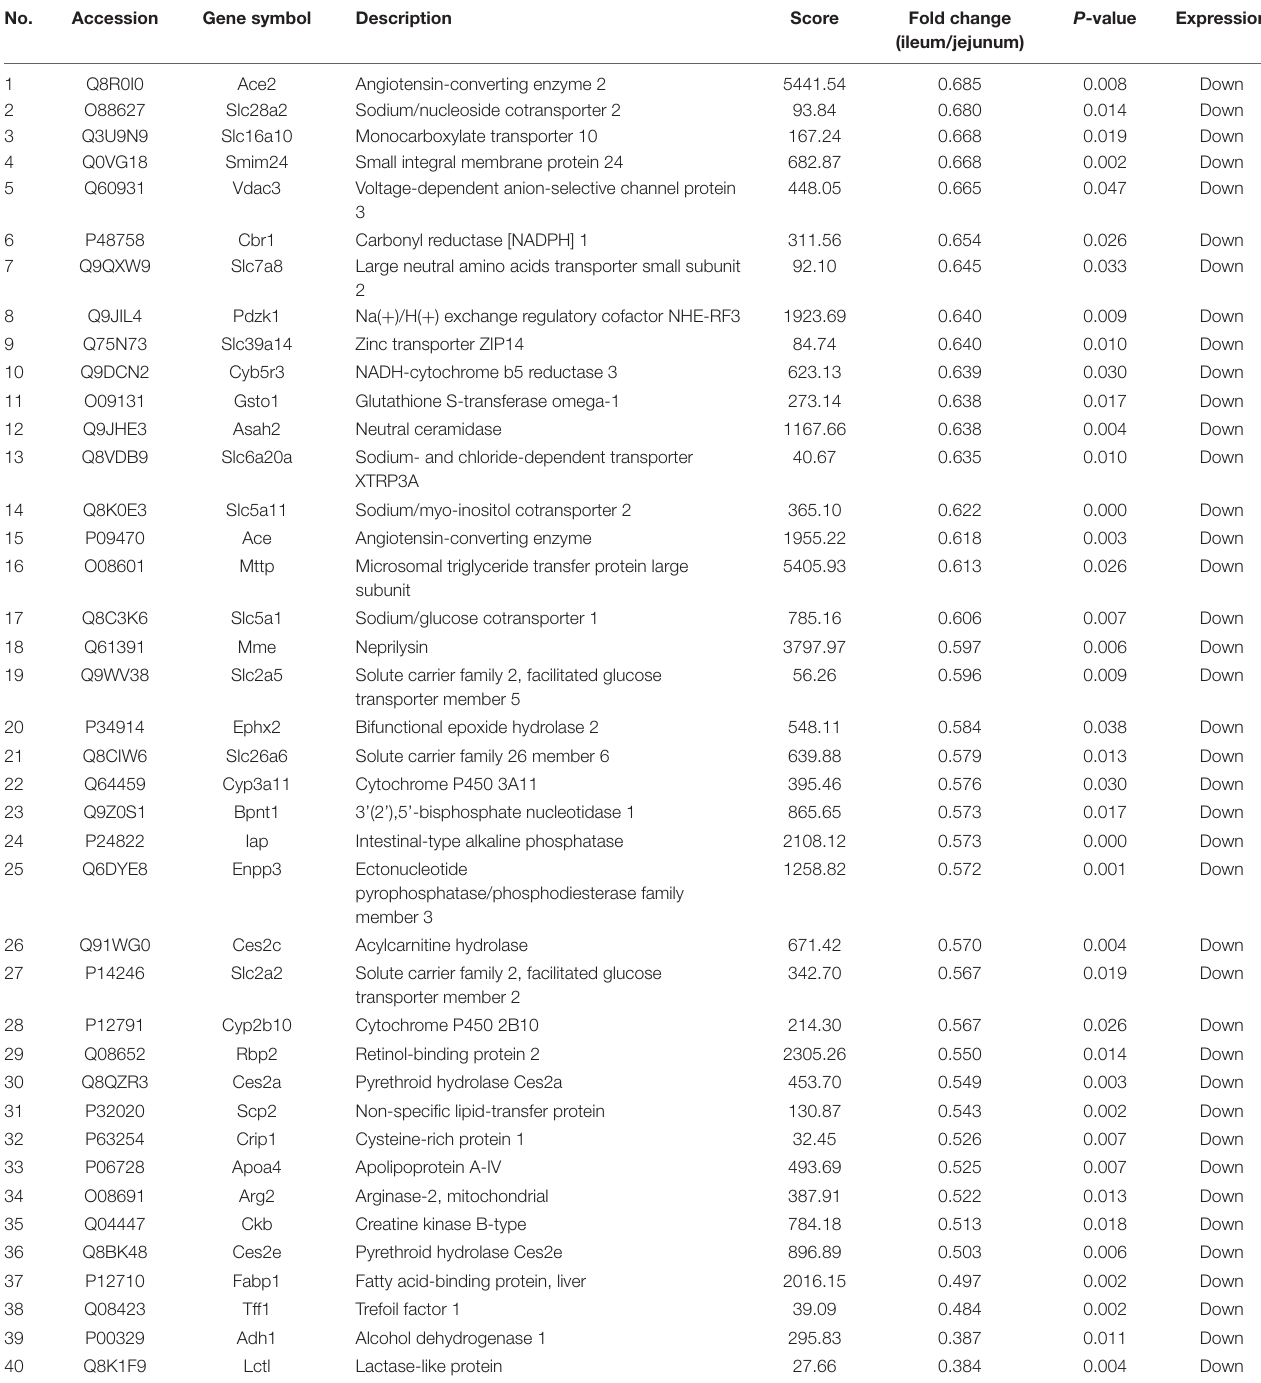
TABLE 2 | Top 40 down-regulated protein information.